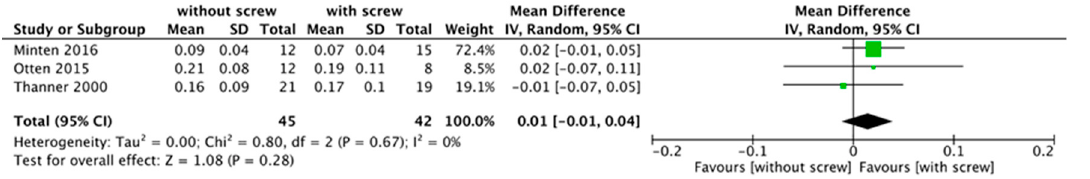
Figure 7. Forest plot of polyethylene wear between the without and with screw fixation groups [11,13,14].